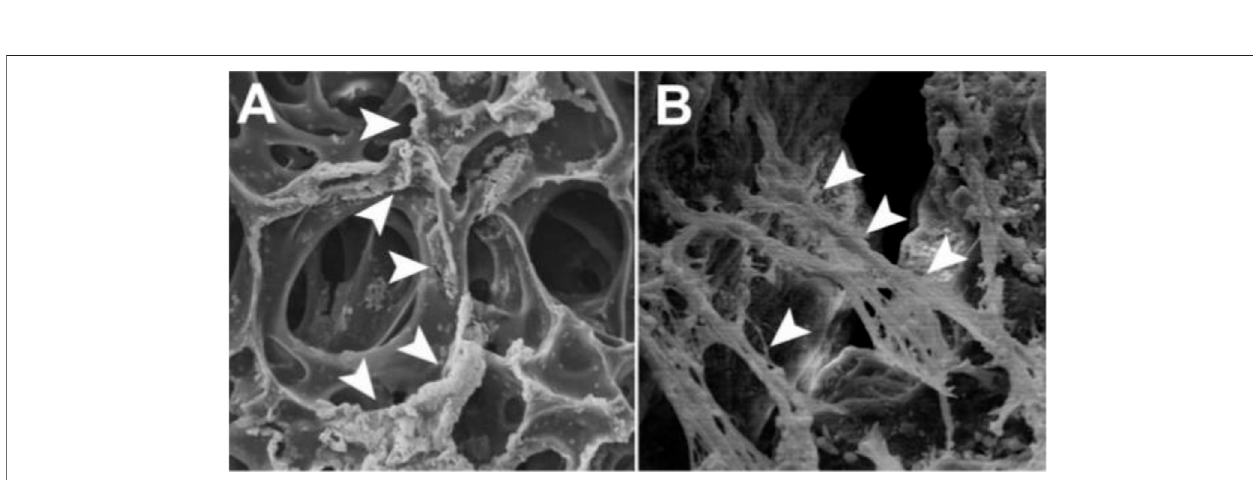
FIGURE4| Ontopofthepolymers,SEMmicrographsofhumanPDL-MSCs (A) Numerouscrushedcellcoloniesseemtobelinkedmostlyby fi brinspongesurface hollows(arrowheads) (B) Tightconnectionsbetweencells and substrate are established by thegrowth ofcytoplasmicprocesses and fi lopodia that serve asanchors for thecells. Attheirdistal extremities, fl opodiaandcytoplasmic processesarecloselyconnectedtobiomimeticmolecules(arrowheads).Reproduced withpermissionfrom (Trubiani et al., 2008).